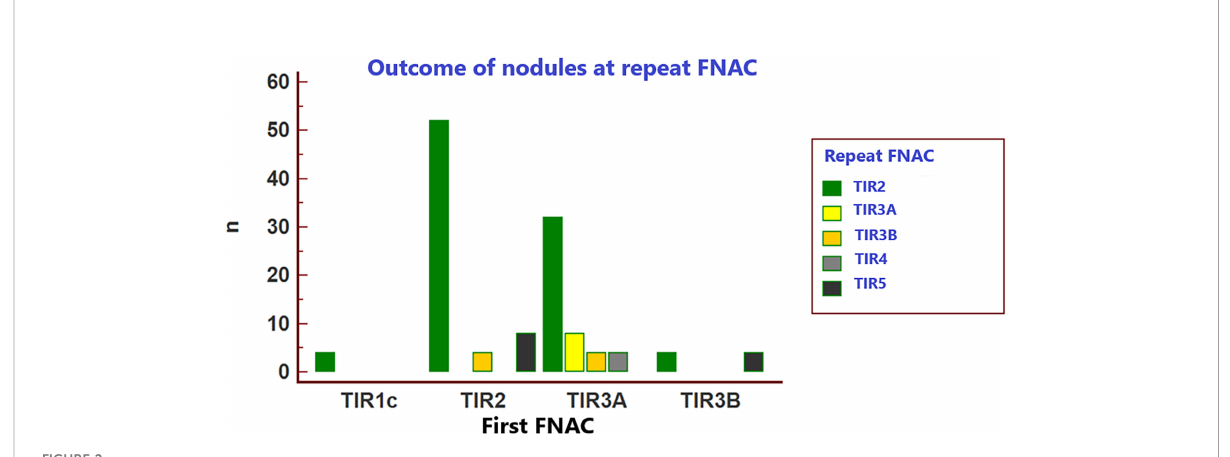
FIGURE 2 Outcome of the 124 included nodules at repeat FNAC.